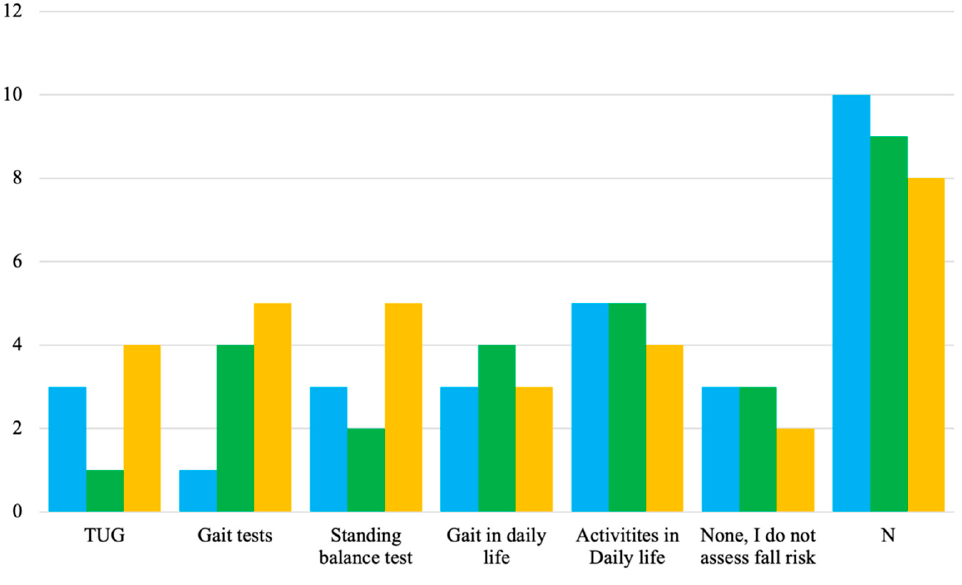
Figure 4. The participants’ familiarity with, and the perceived relevance and feasibility of, the FRA methods used in the SFRA methods selected in sub-study 3.